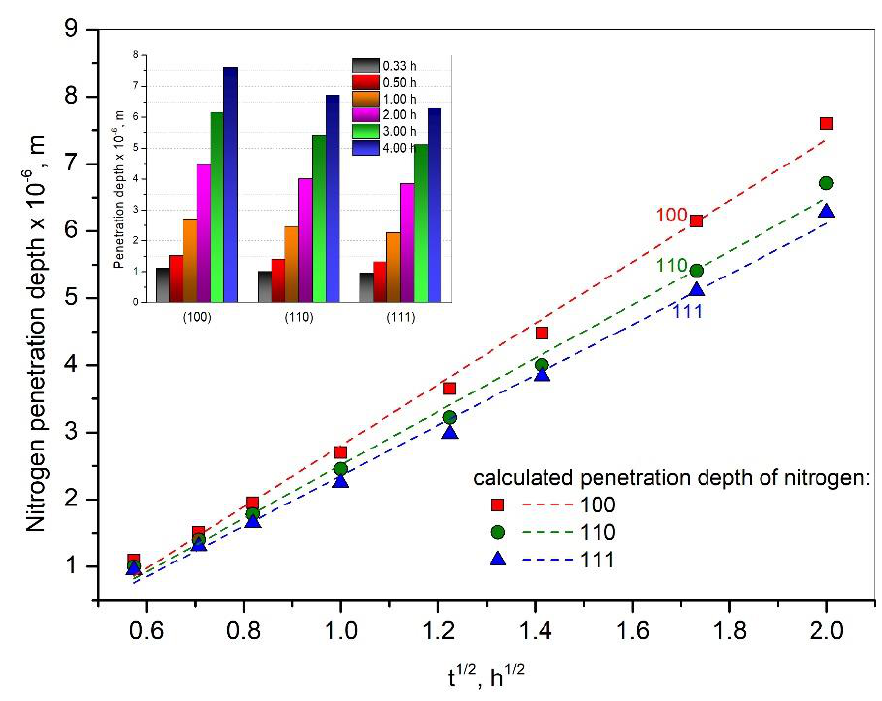
Figure 6. Figure 6. Calculated time dependencies of nitrogen penetrations depth for different crystalline orientations.